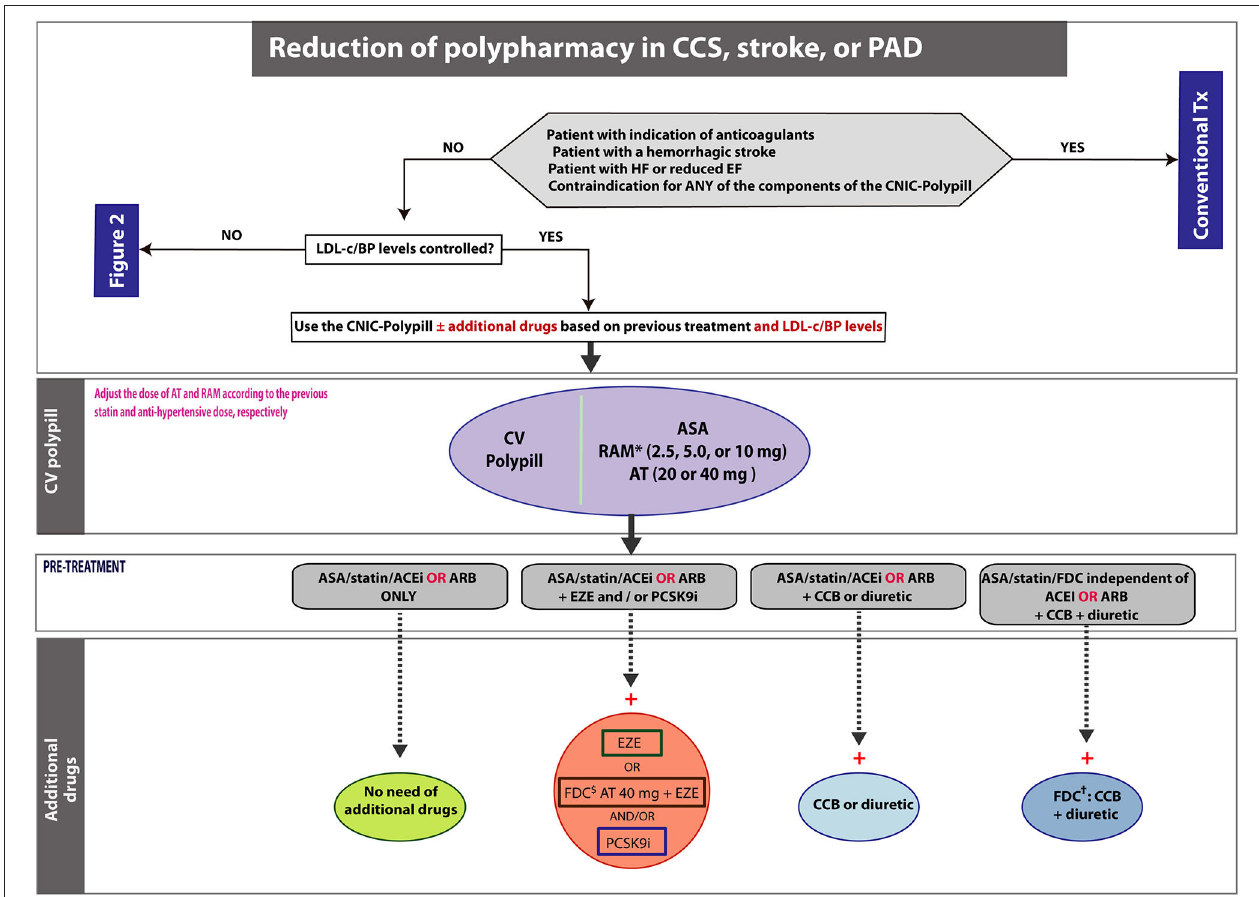
FIGURE 3 | Algorithm showing the steps and scenarios to reduce the pill burden with the CNIC-Polypill in patients treated for chronic CVD. Note: *Dose adjusted to previous ACEI/ARB dose and renal function. $ Use only if the patient does not develop side effects to atorvastatin 80mg (or equivalent doses of another statin). combination is available. ACEI, angiotensin-converting enzyme inhibitor; ARB, angiotensin II receptor blocker; ASA, acetylsalicylic acid; AT, atorvastatin; BP, blood pressure; CCB, calcium channel blocker; CCS, chronic coronary syndrome; EZE, ezetimibe; FDC, fixed-dose combination; LDL-c, low-density lipoprotein cholesterol; PAD, peripheral artery disease; PCSK9i, proprotein convertase subtilisin/kexin type 9 inhibitor; RAM, ramipril; Tx,